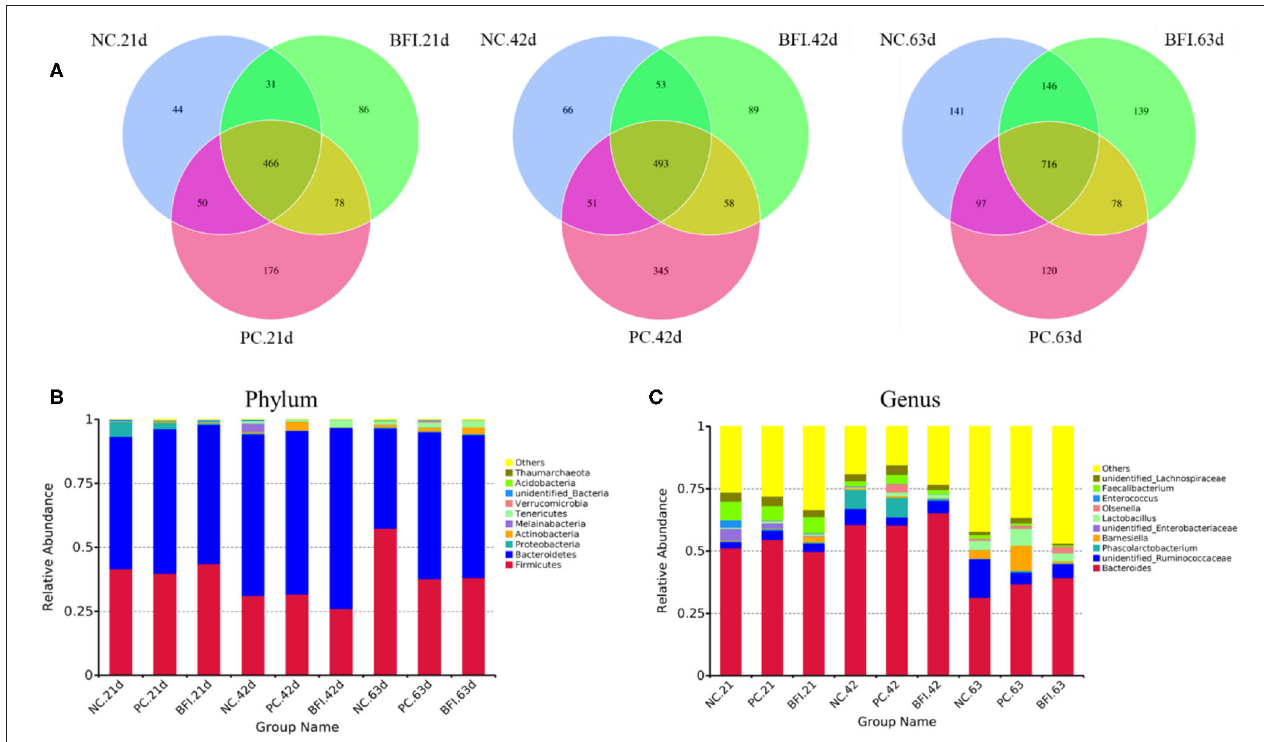
FIGURE 1 | The Venn diagram and bacterial community composition of yellow-feathered broilers fed with antibiotics or compound probiotics-supplemented diets. (A) The Venn diagram of OTUs at starter, grower, and finisher phases. Microbial composition in the cecum at the phylum (B) or genus (C) level. Relative abundance < 1% were combined into “other.” NC, negative control without in-feed antibiotics. PC, positive control with in-feed antibiotics with 200 mg/kg of oxytetracycline calcium + 250 mg/kg of nasiheptide. BFI, compound probiotics consisting of heat-inactivated Bacillus subtilis and Lactobacillus acidophilus